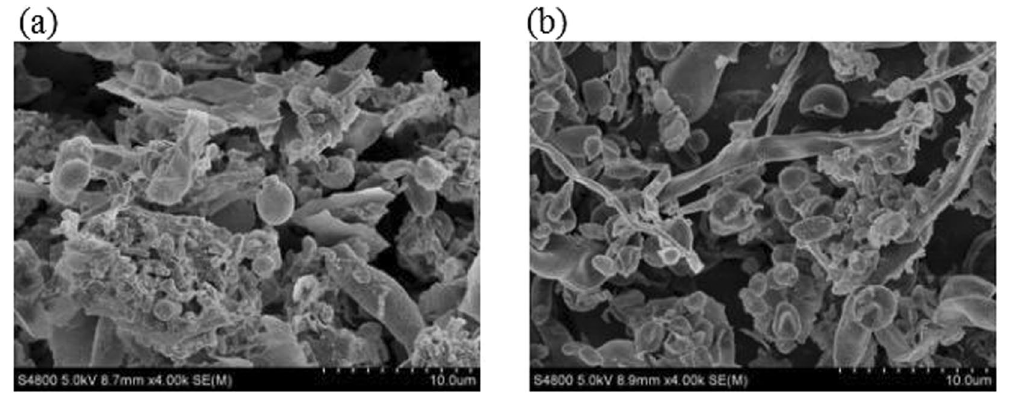
Figure 2. SEM photographs of different carriers. ( a ) Wood chips; ( b ) Maize